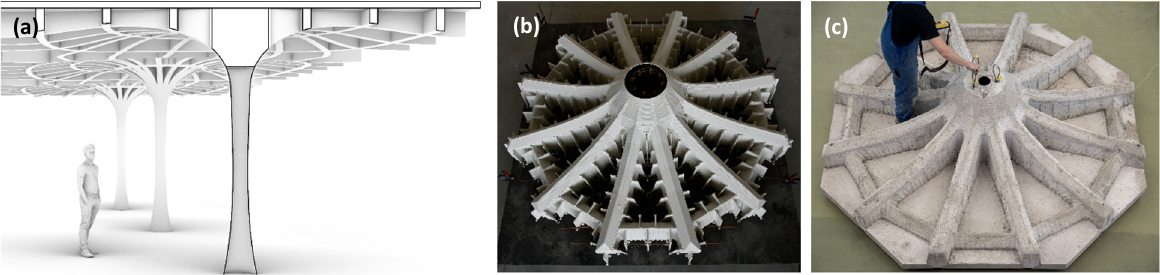
Figure 7. Ribbed slabs with thin polymeric 3D ‐ printed formwork: (a) visualisation of the proposed slab system; (b) robotically 3D printed formwork; (c) finished optimised column ‐ slab